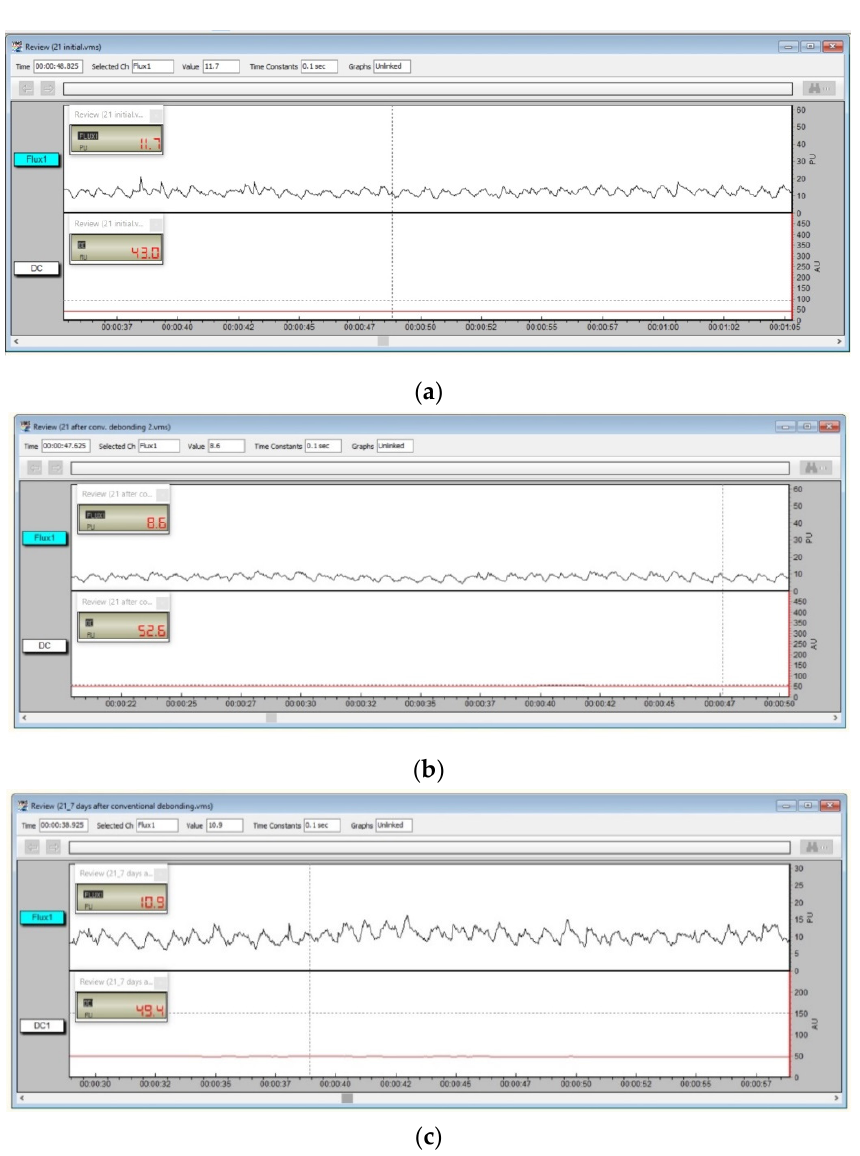
Figure 5. Laser Doppler pulp level signal for tooth 2.1. before debonding ( a ), immediately after conventional debonding ( b ), and seven days after the treatment ( c ).